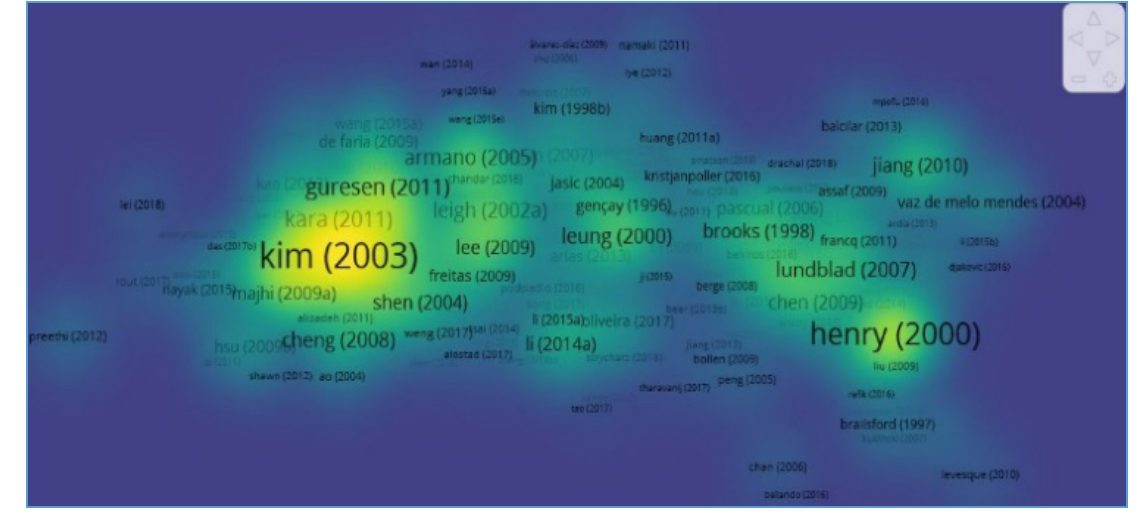
Fig. 4. Density visualization (source: